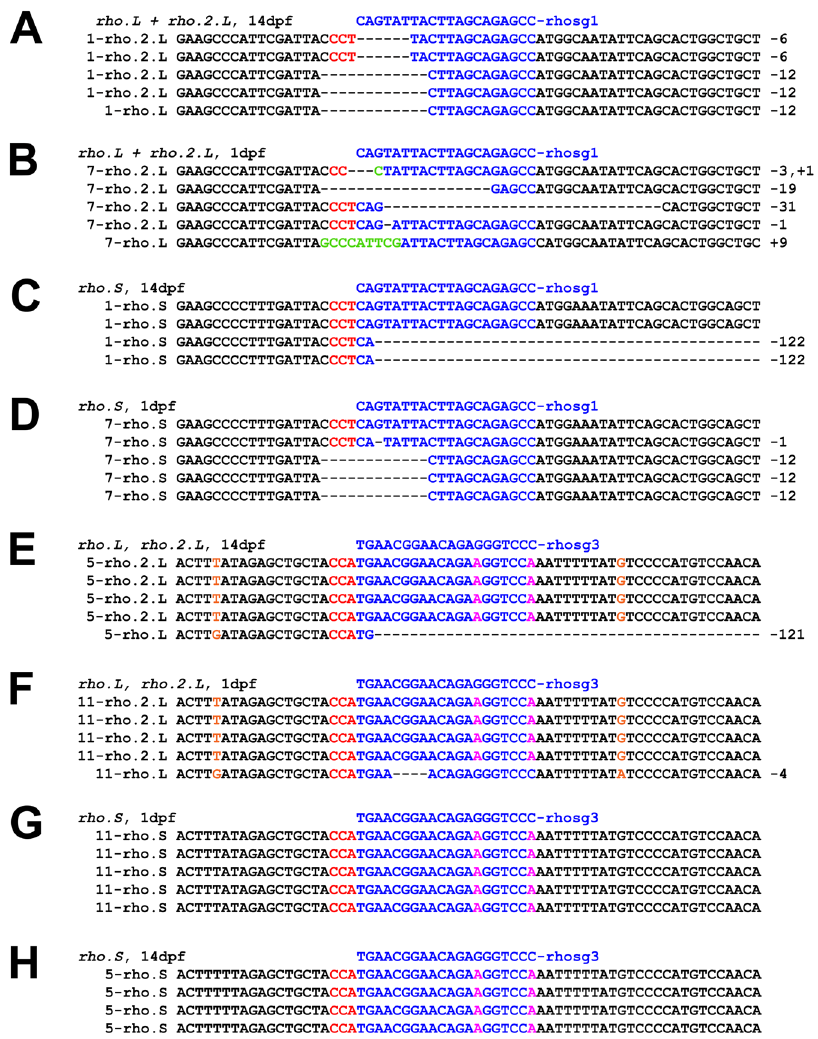
Figure 4. Characterization of indels by sequencing genomic DNA clones: ( A–H ) Sequences obtained from individual pBluescript-SKII + clones of PCR products derived from genomic DNA isolated from F0 embryos at either 1 dpf or 14 dpf (as indicated) edited with Cas9 mRNA + rhosg1 or rhosg3 (as indicated). The reverse complement sequence of the guide RNA is shown above the individual genomic DNA sequences in blue. The targeted sequences are also shown in blue. Mismatches with the guide RNA are shown in magenta. Insertions are noted in green. The protospacer adjacent motif (PAM) sequence is shown in red. Bases that are diagnostic of rho.L vs. rho.2.L are shown in orange. The number at the beginning of each sequence corresponds to sample numbers for direct sequencing results shown in Fig.